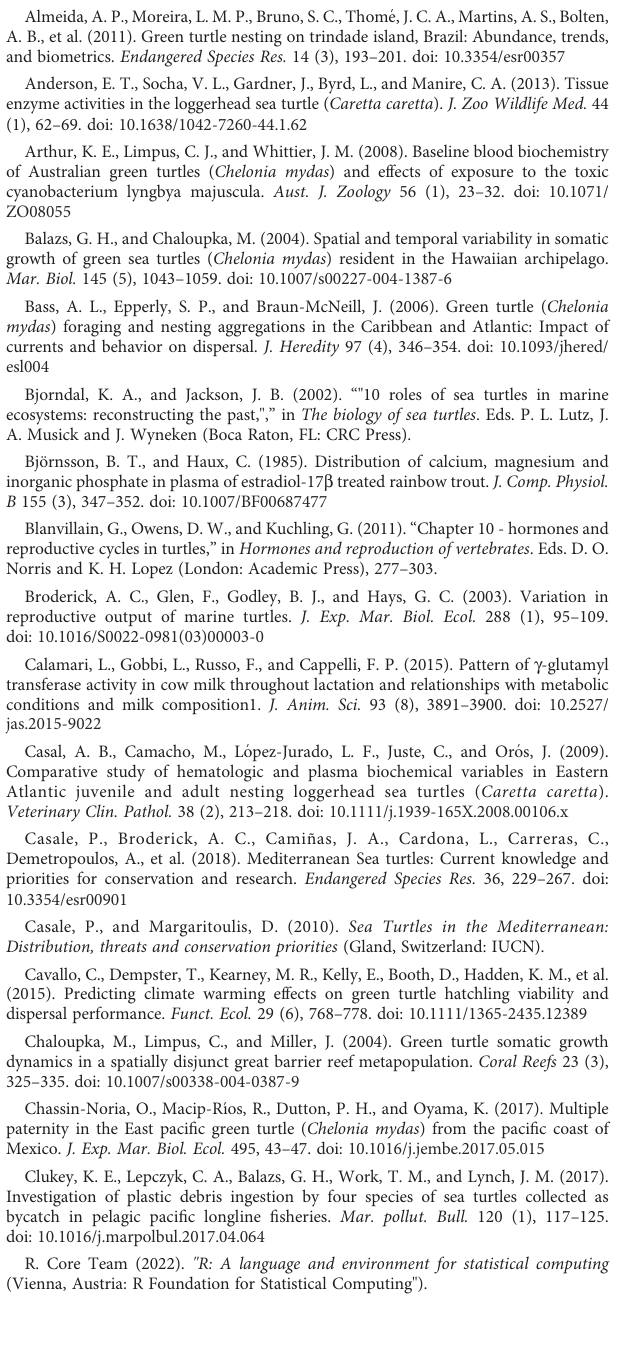
SUPPLEMENTARY TABLE 1 Information of location, tagging and physical data of the green sea turtles SUPPLEMENTARY TABLE 2 Nesting activity of green turtle females in the years 2018-2020. Ukn